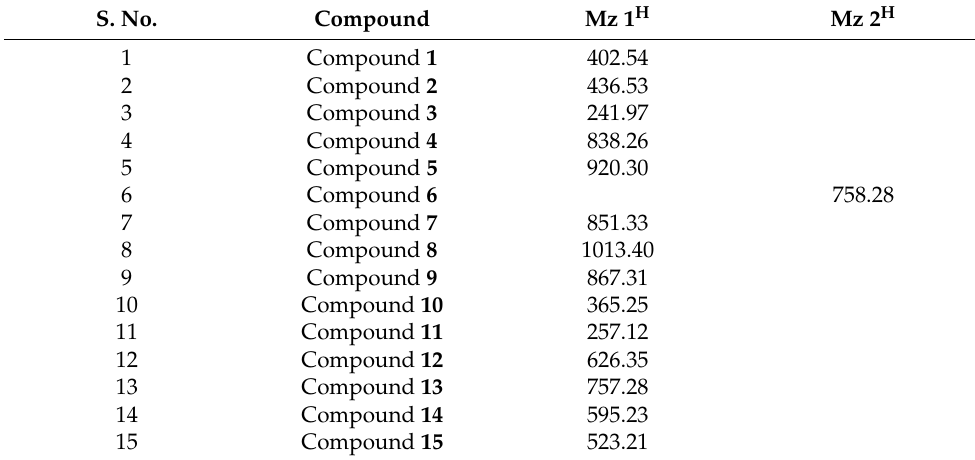
Table 1. Mass-spectrometric identification of peptides from S. amaranthoides . S.